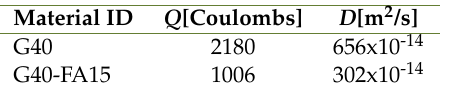
Fig. 5. Granulometric curve of the concrete G40 with fly ash (G40-FA15). The value of D in Table 2 for each concrete type (without or with fly ash) is the average values measured on three samples. However, the variability in the measurement is negligible. Table 2. Testing chloride ion diffusion in concrete with- out and with fly ash Table 3. Input data and the diffusivity coefficients of